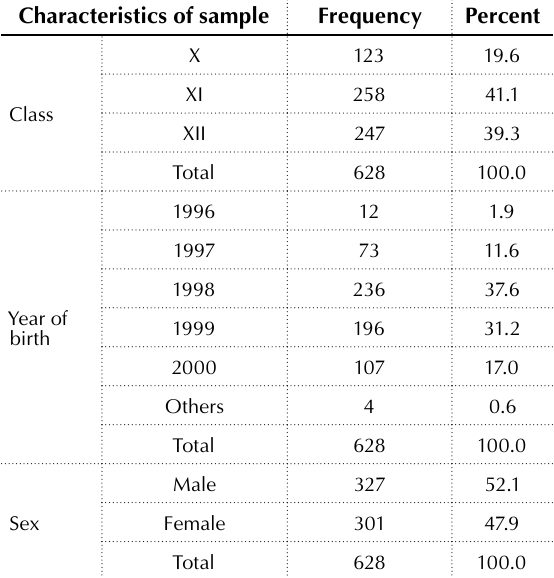
Table 2. Participant profile Characteristics of